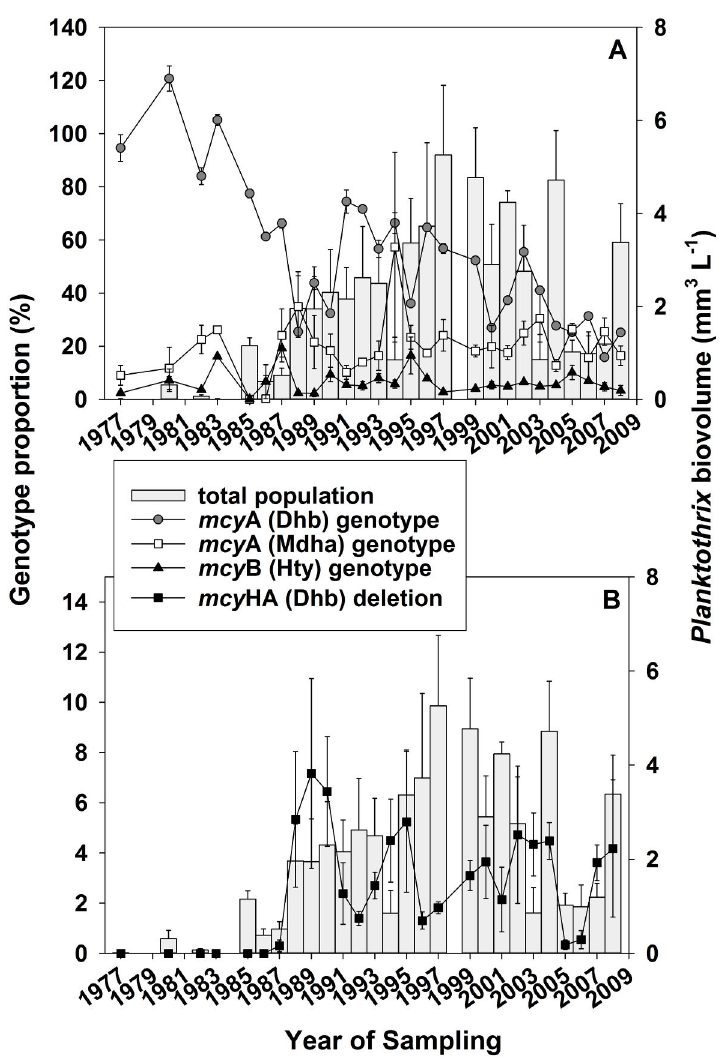
Figure 4. Proportion of individual genotypes as determined by qPCR in Lake Zürich. (A) Time course of annual mean ± SE proportion of the Dhb, Mdha, and Hty genotype and (B) of the mcy HA deletion genotype and the total population biovolume (grey bars) of Planktothrix (mm 3 L -1